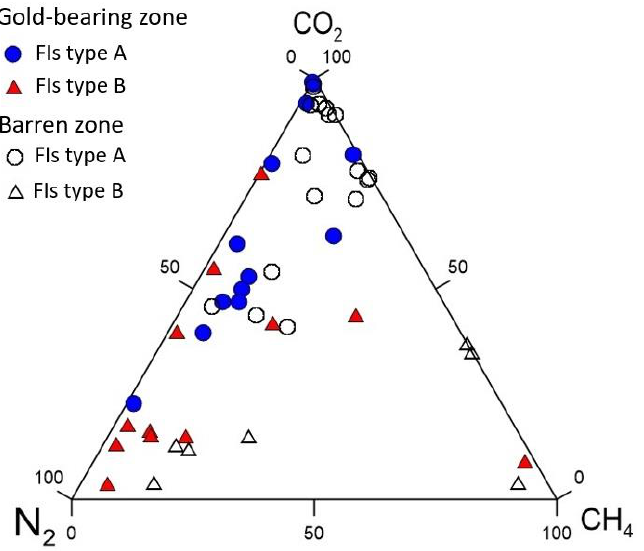
Figure 6. Compositions of the gas phases of fluid inclusions in quartz from the Dobroe gold deposit (Raman spectroscopy data).